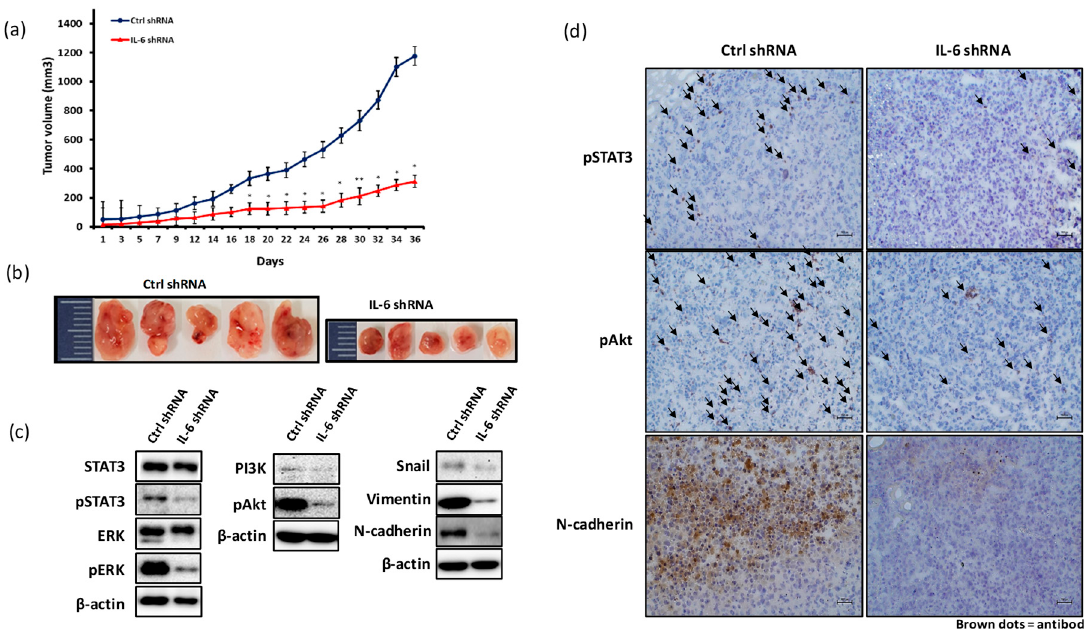
Figure 5. Blockade of IL-6 expression inhibits MDA-MB-231-derived tumor growth and metastasis. MDA-MB-231 cells were transfected with IL-6 shRNA or control shRNA lentivirus plasmid. BALB/c nude mice were subcutaneously injected with 5 × 10 6 MDA-MB-231 cells transfected with IL-6 shRNA or control shRNA into the dorsum next to right hind leg. After 14 days, tumor volume was measured using caliper every other day. ( a ) Tumor growth curve. ( b ) Tumor photograph. Expression of proteins in tumor tissues analyzed with western blotting and immunohistochemistry (IHC). Expression of STAT3 (and pSTAT3), ERK (pERK), PI3K, pAkt, snail, vimentin, and N-cadherin ( c ). Black arrows indicate the dots of pSTAT3, pAkt, and N-cadherin ( d ) (scale value is 100px). Significant differences are shown: * p < 0.05, ** p < 0.001.